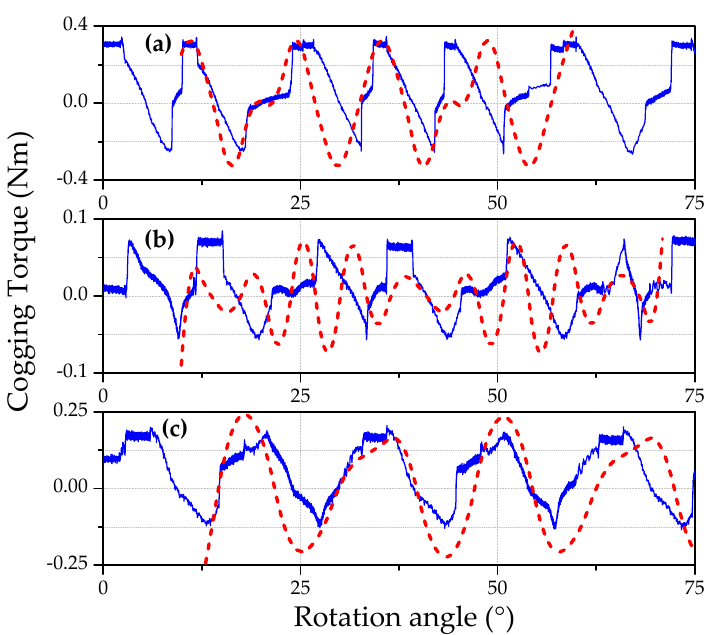
Figure 12. Comparison between analytical and measured cogging torque for three relative angles between opposite teeth. ( a ) 0°; ( b ) 7.5°; ( c ) 11.25°. The solid lines represent the measured cogging torque, and the dashed lines represent the calculated cogging torque.